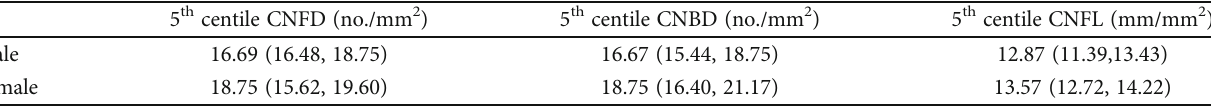
Table 4: Corneal nerve parameter reference